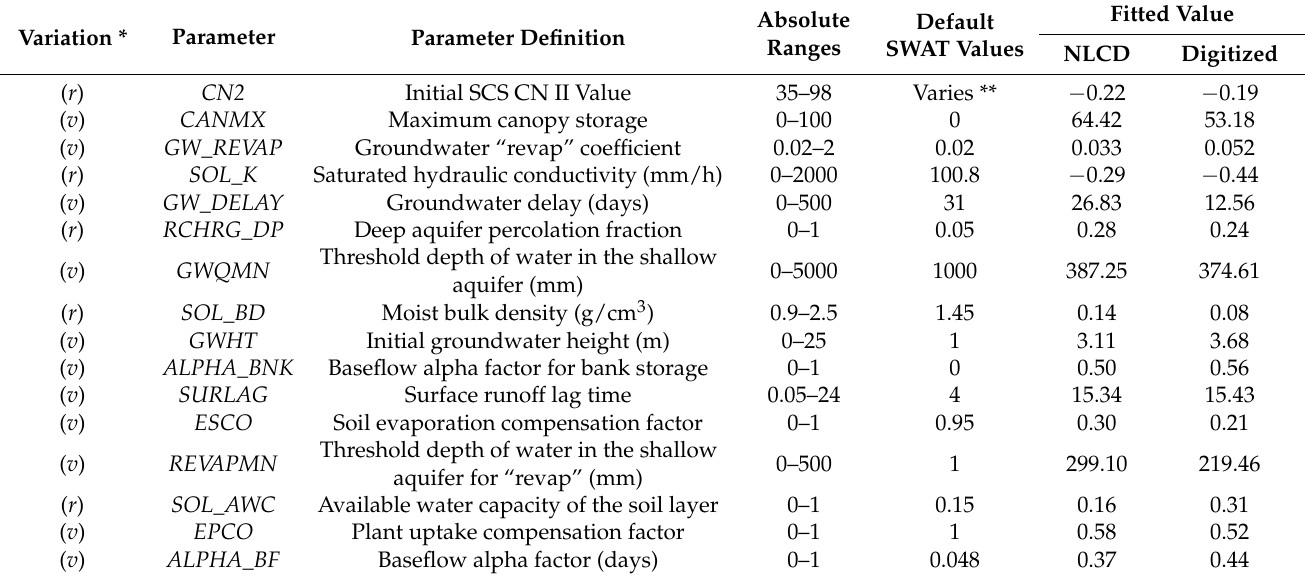
Table 4. Calibrated model parameters and fitted values for each LULC